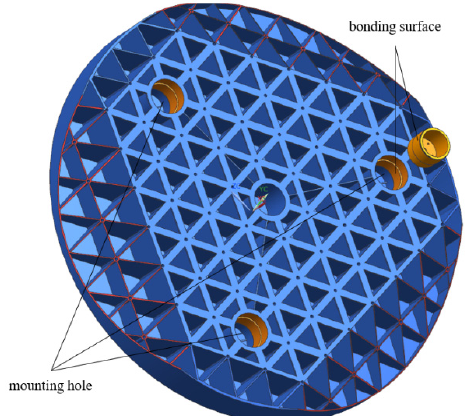
Figure 2. Connection method of the mirror body and rigid connector.